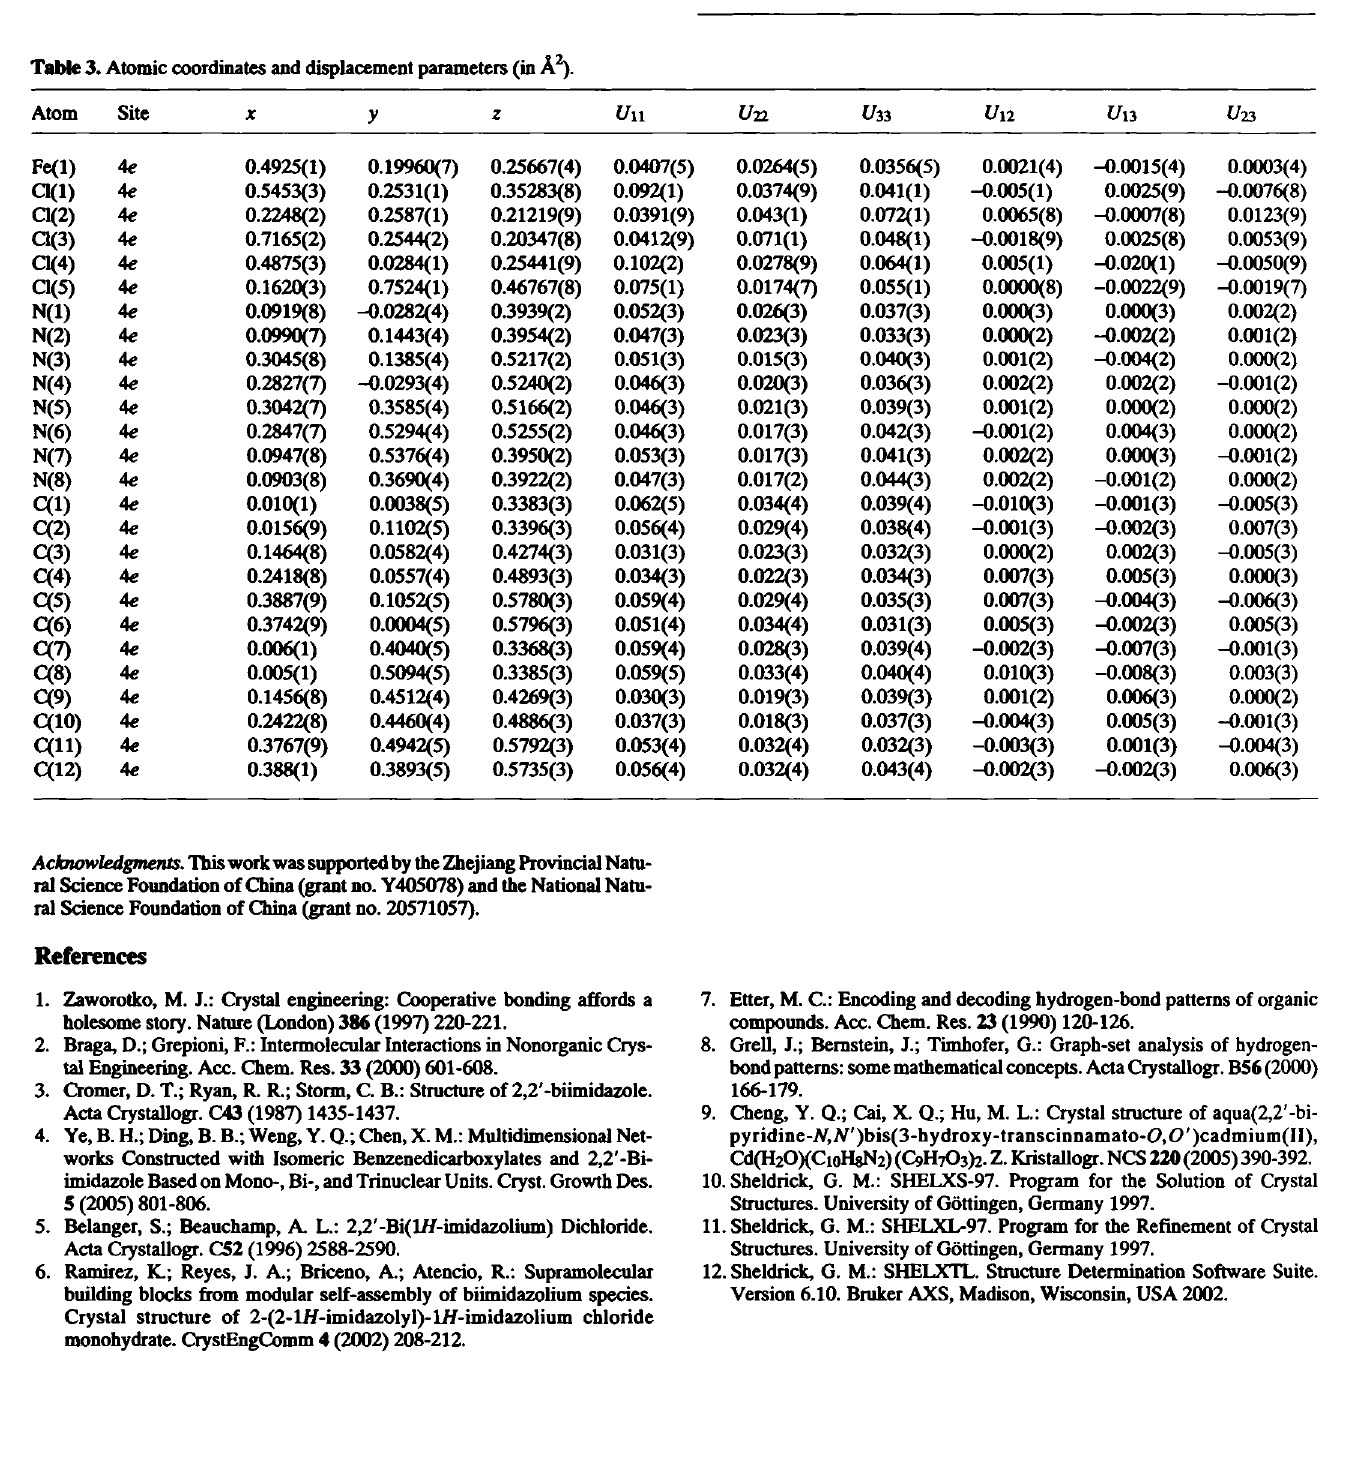
Table 3. Atomic coordinates and displacement parameters (in Ä 2